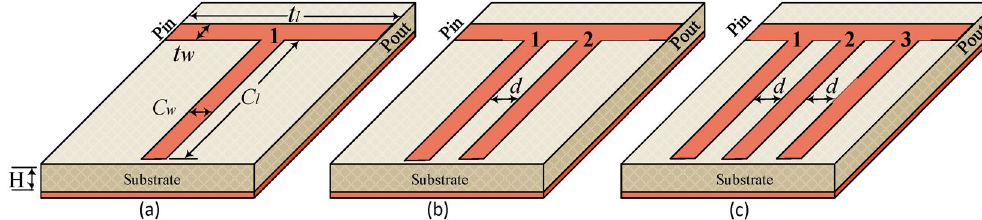
Figure 2. A schematic view of the microstrip resonator is provided. The thickness of substrate is 0.76 mm with permittivity 2.94. Each resonator consists of open-stub connected to the guiding medium. Three different kind of resonators are considered having ( a ) single, ( b ) double, ( c ) triple open-stubs with dimensions of C l = 3.5 cm, C w = 2 mm, t l = 2 cm, t w = 3.16 mm, H = 0.76 mm and d = 2